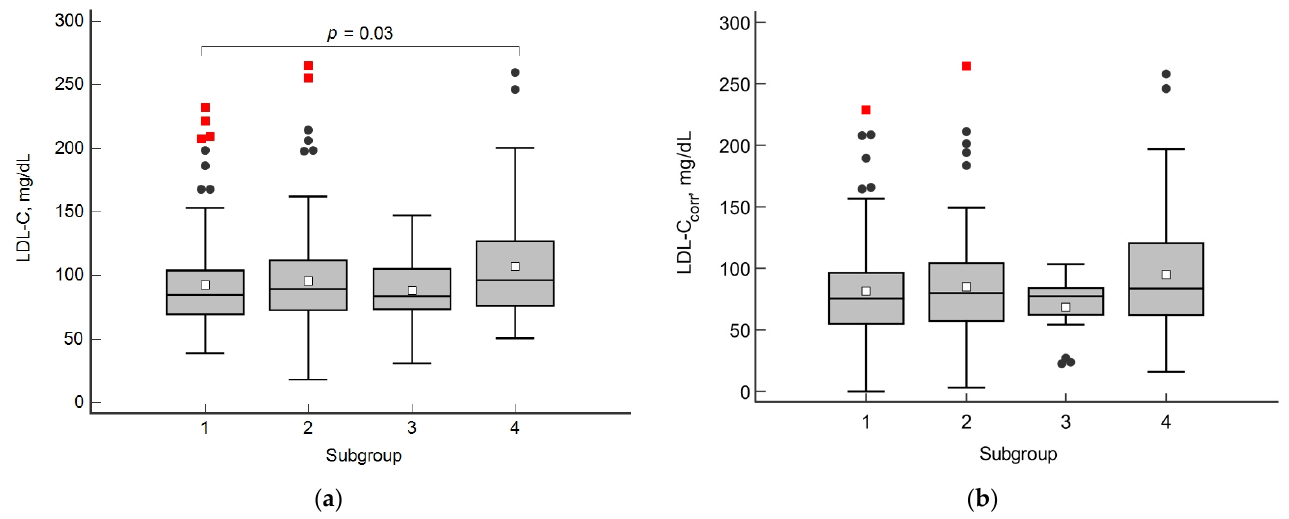
Commented [M2]: Please remove "of spacecraft" from the caption for figures 3 and 4. Formatted: Highlight